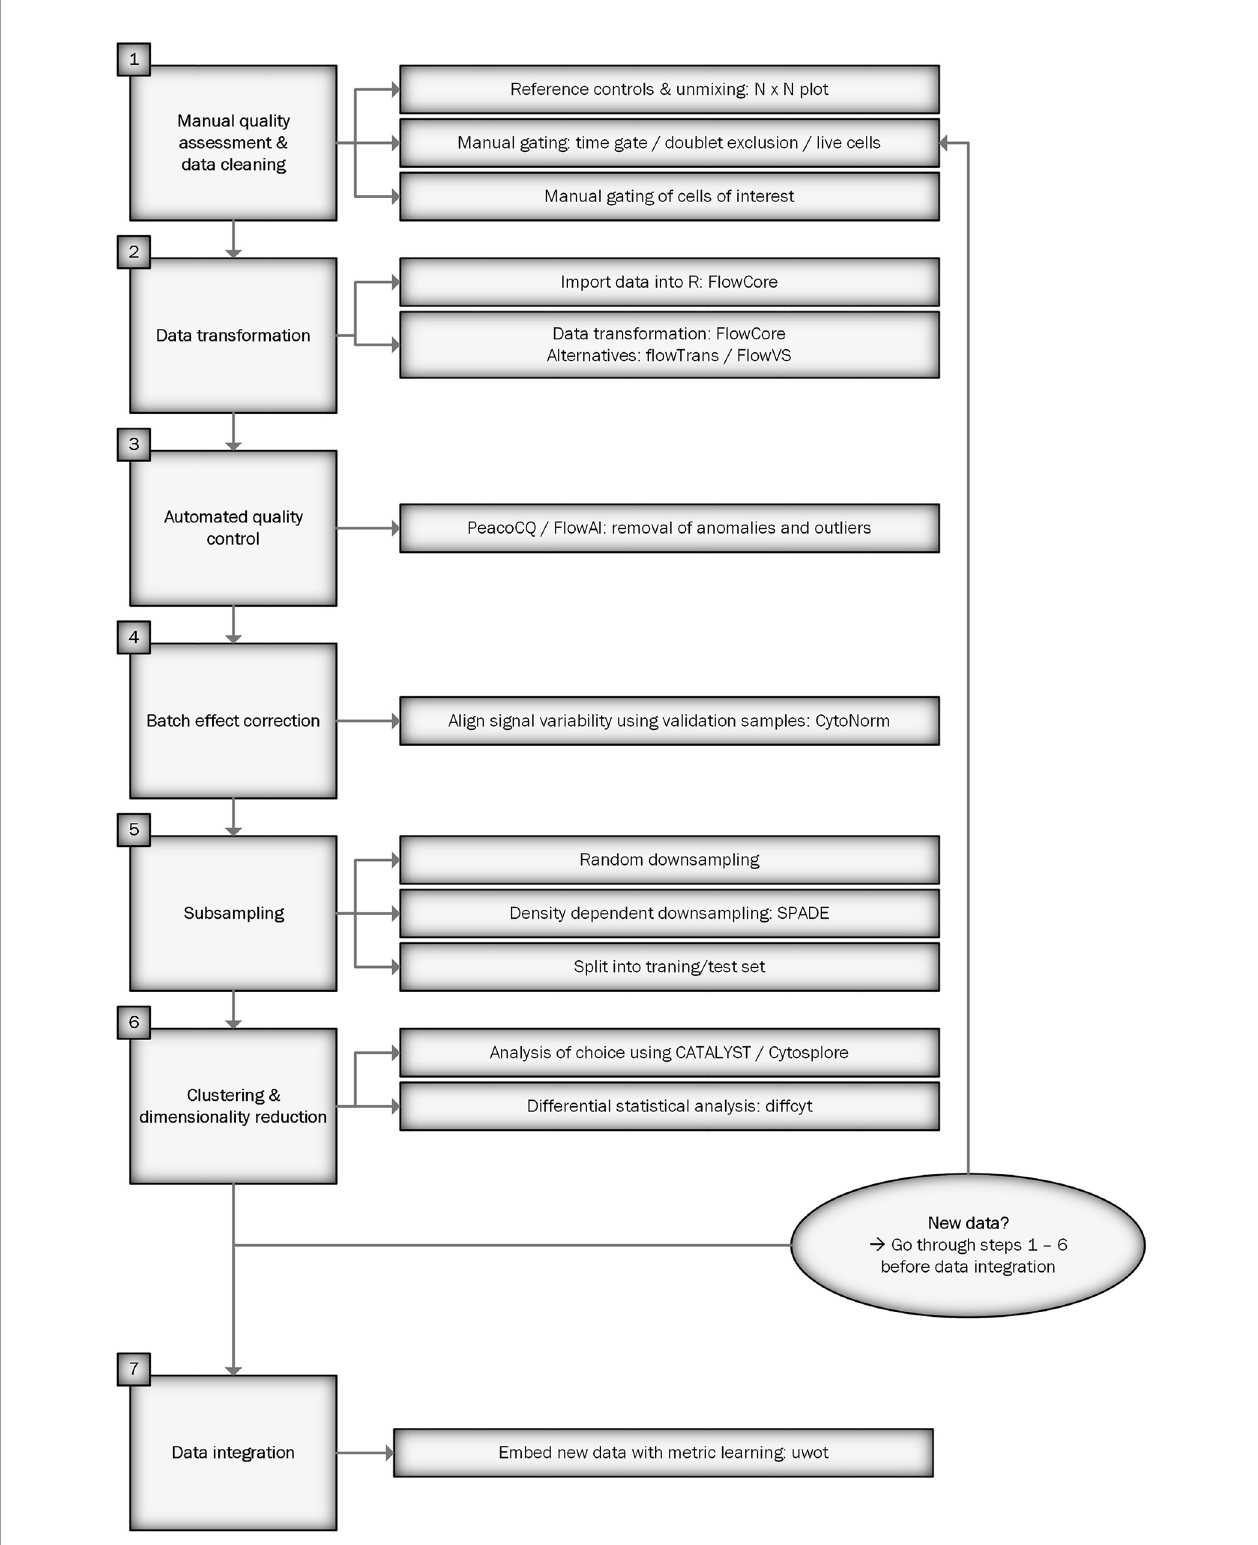
FIGURE 1 | Flowchart of spectral fl ow cytometry work fl